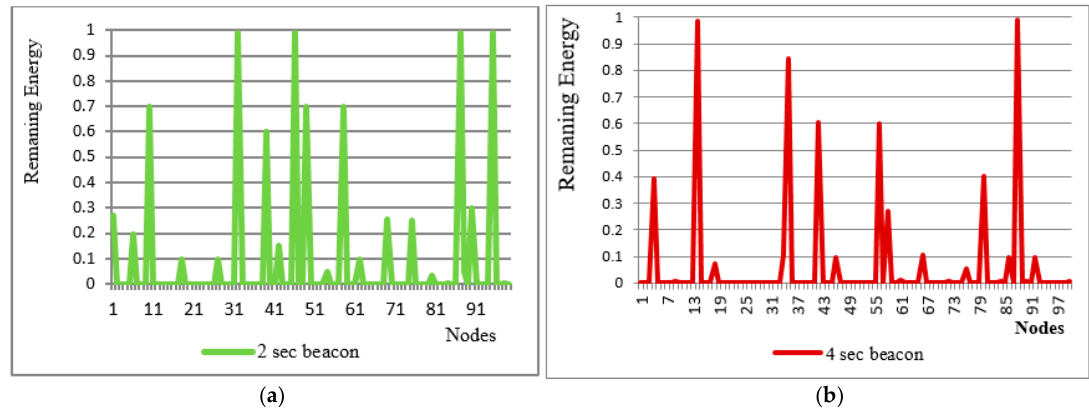
Figure 11. Effect of beaconing period on energy utilization ( a ) 2 s beaconing ( b ) 4 s becoming.